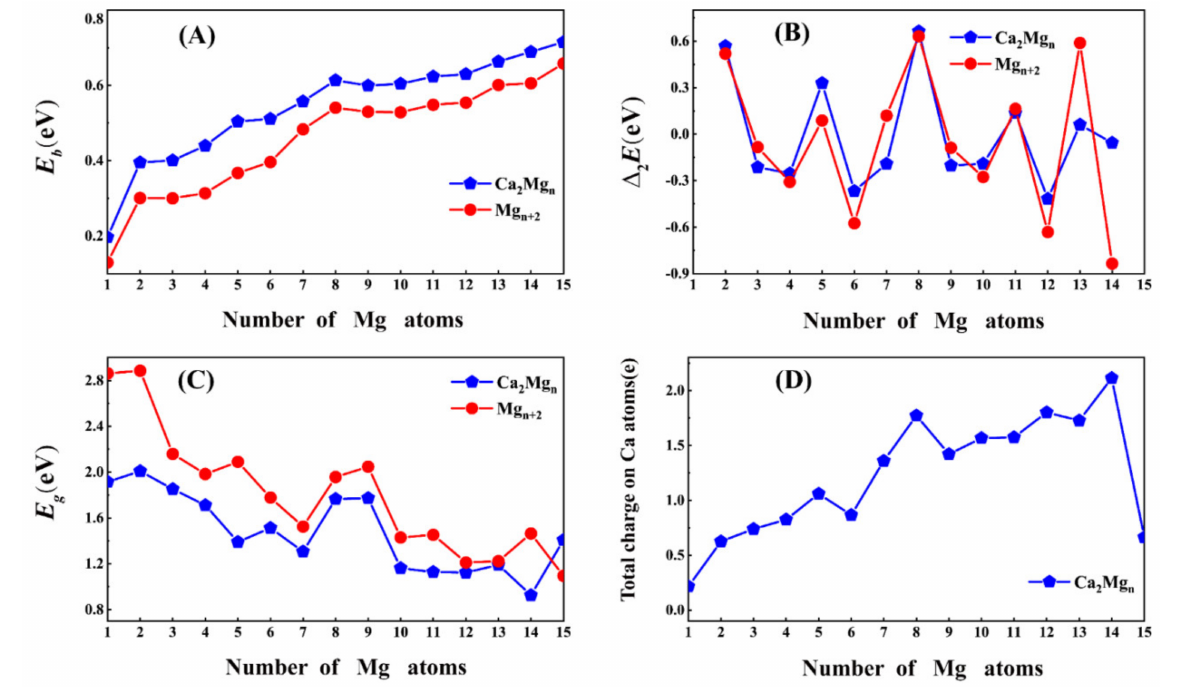
Figure 2. ( A ) E b , ( B ) ∆ 2 E , ( C ) E g and ( D ) the total charges on Ca atoms in the ground state of Ca 2 Mg n ( n = 1–15) clusters.